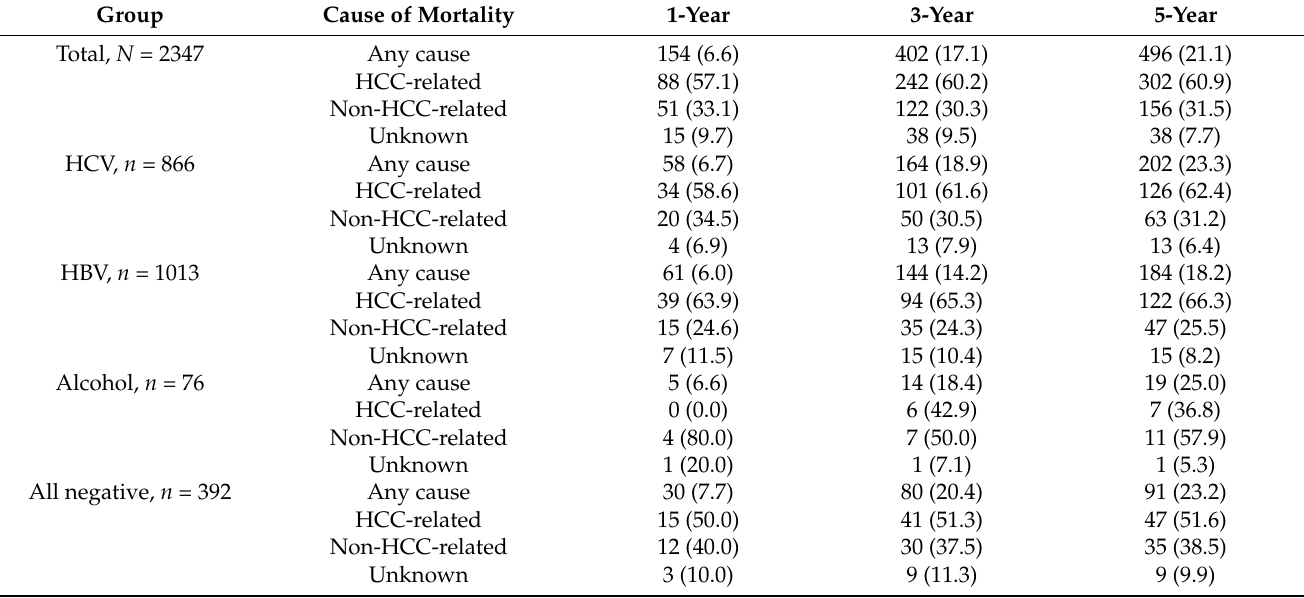
Table 3. Cause-specific mortality among patients who underwent curative